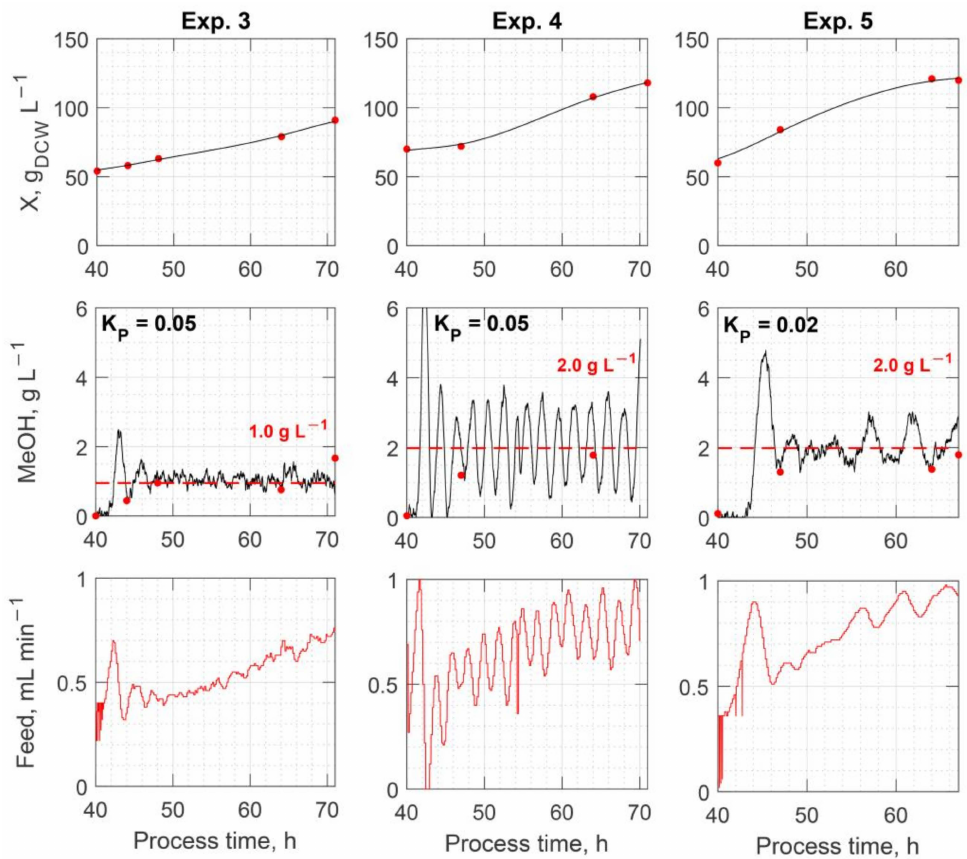
Figure 5. Three P. pastoris cultivations at increased residual methanol levels, illustrating the effect PI parameter ( K p ) tuning has on control accuracy. Horizontal dashed line indicates the methanol concentration set point. Reprinted/adapted with permission from Ref. [19]. 2023, Springer